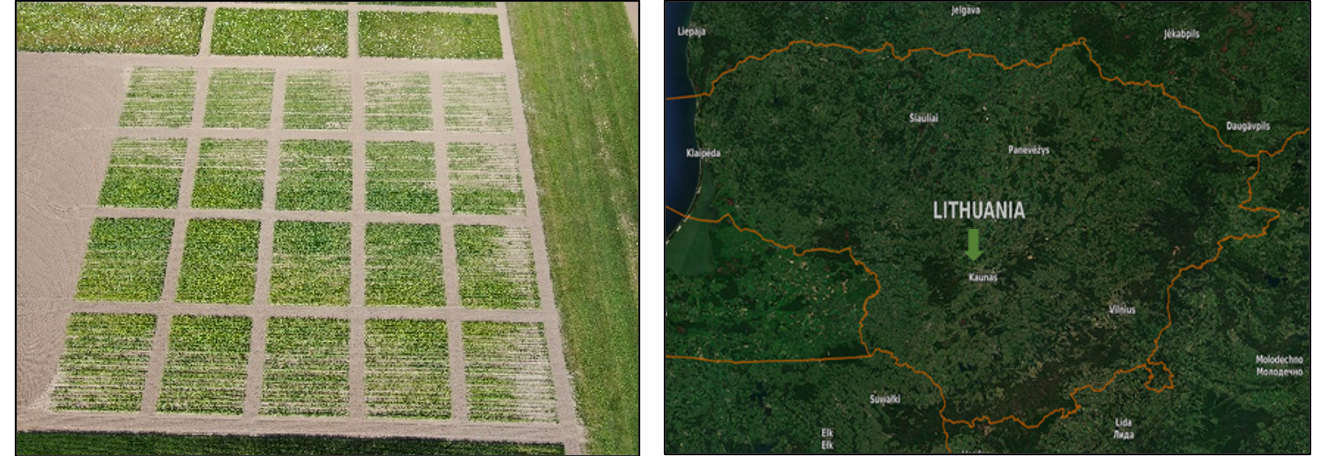
Figure 1. General view of field experiment. Coordinates: 54°53 ′ 8.93 ″ N latitude, 23°50 ′ 19.86 ″ E lon- gitude.